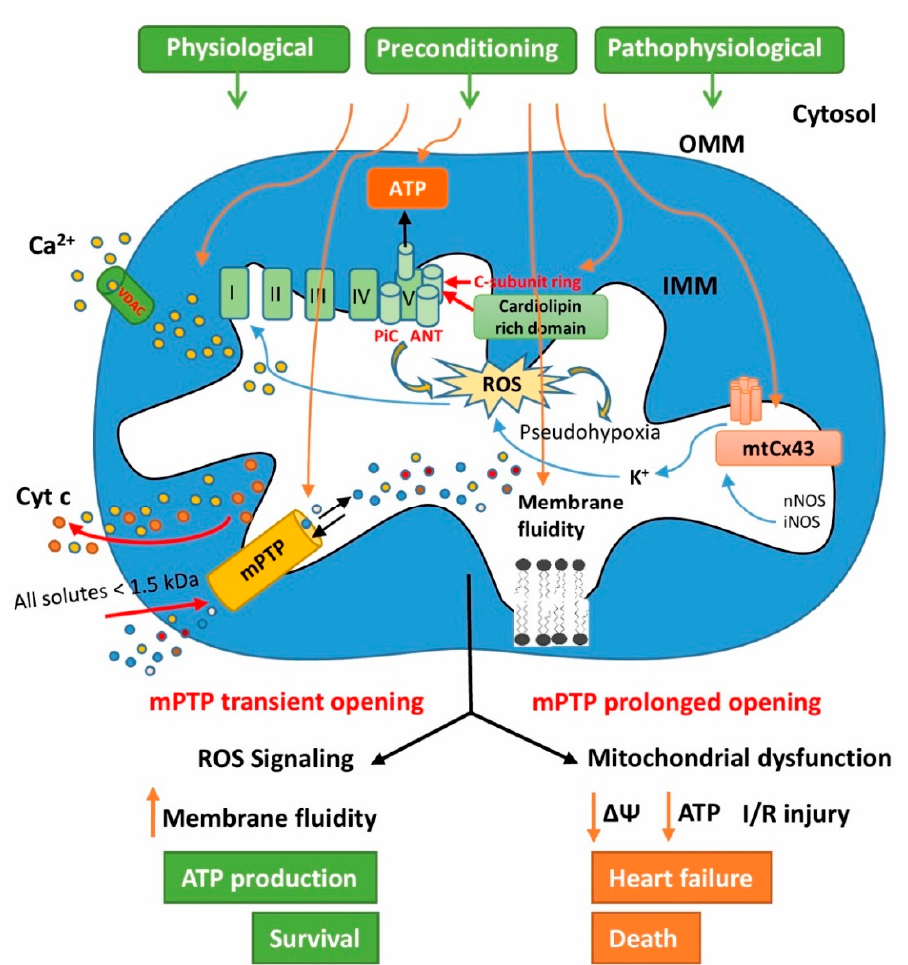
Figure 1. Diagram of signaling pathways affecting mitochondrial permeability transition pores (mPTP) regulation in preconditioned and pathological myocardium. For details, see the text.